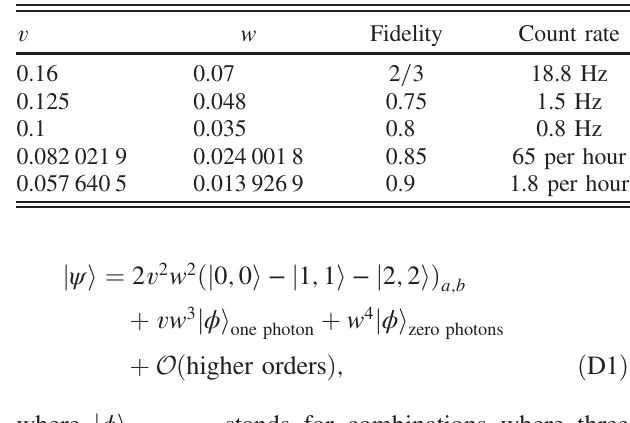
TABLE I. Fidelity and count rates for heralded three-dimen- sional Bell states.